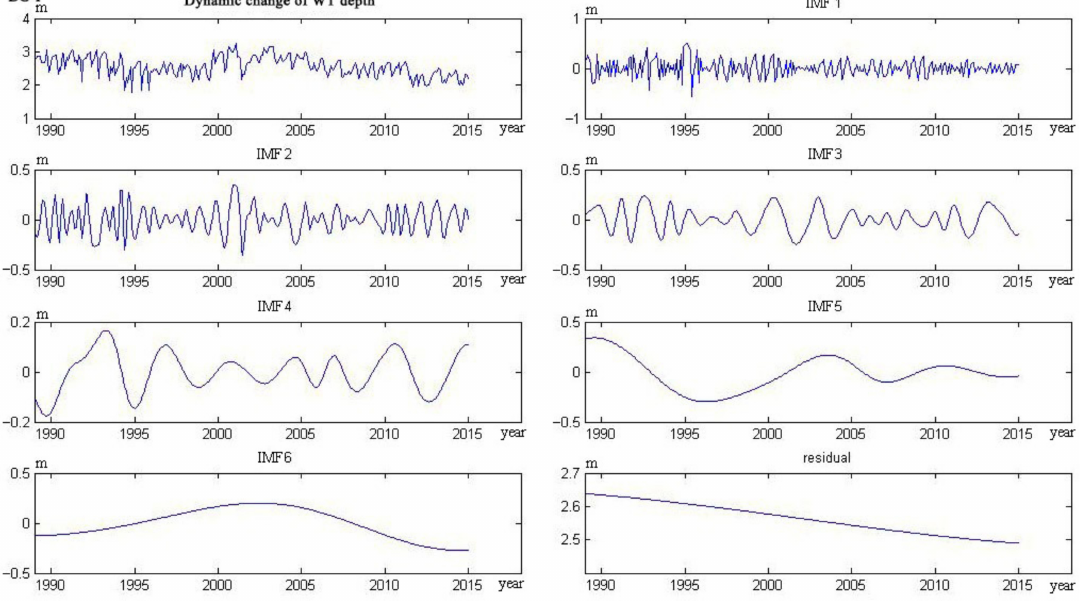
Figure A1. Decomposition of groundwater time series data of well BG1.